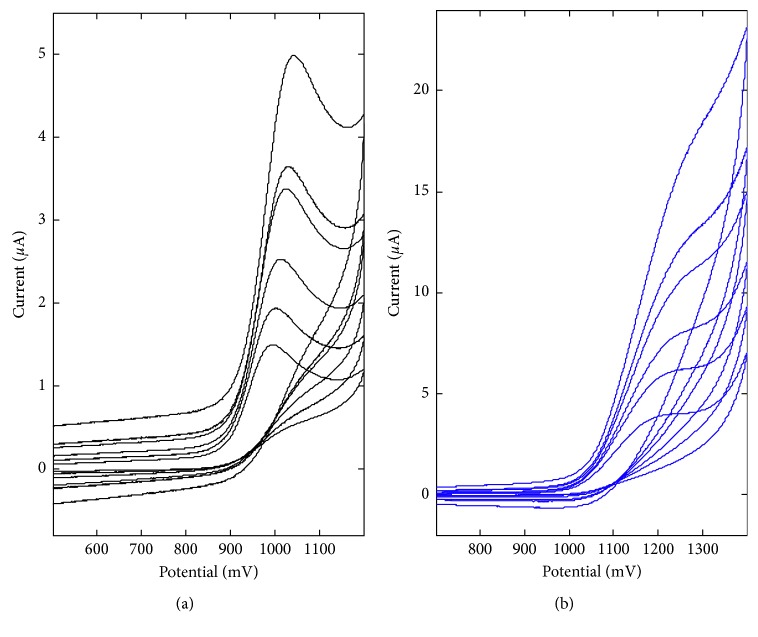
Cyclic voltammograms by the scan rate of 0.025, 0.05, 0.1, 0.2, 0.25, and 0.5 V s−1, obtained for 13.92 mg L−1 of anethole in 0.1 mol L−1 acetate buffer on (a) BDDE and (b) La2O3/CPE.